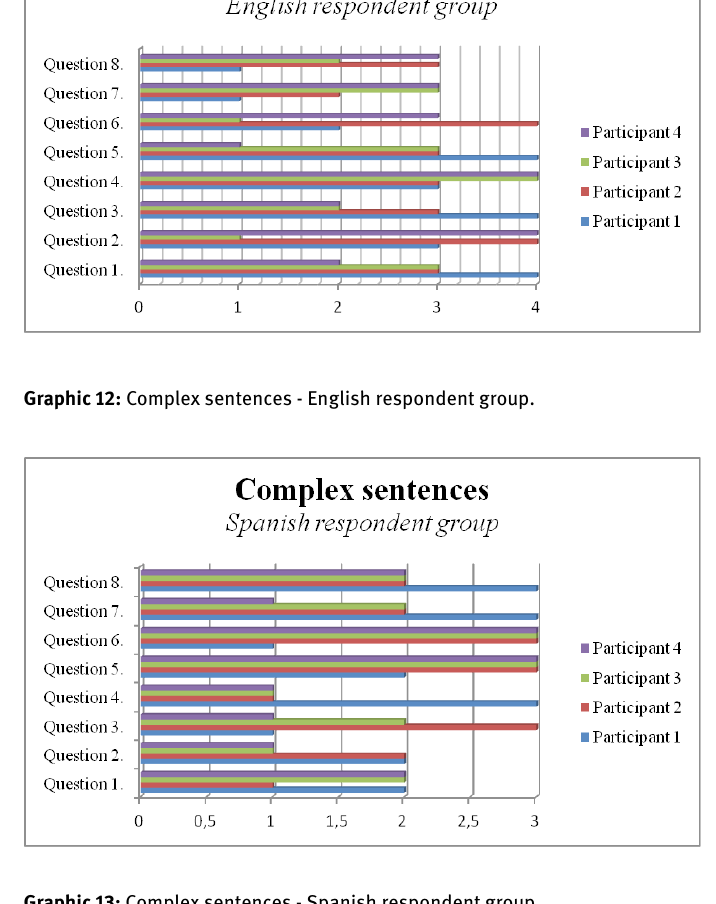
Graphic 13: Complex sentences - Spanish respondent